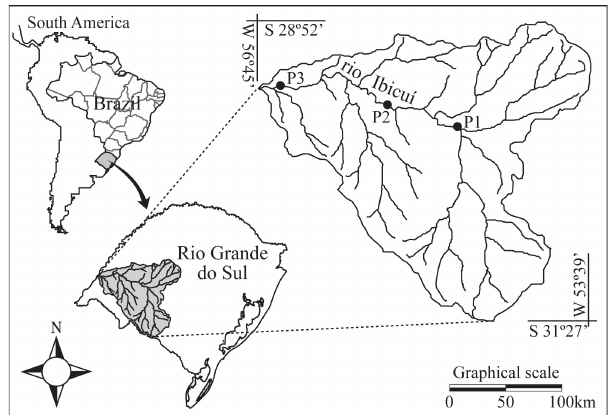
Fig. 1. Map with location of sampling points. P1 = Point 1; P2 = Point 2; P3 = Point